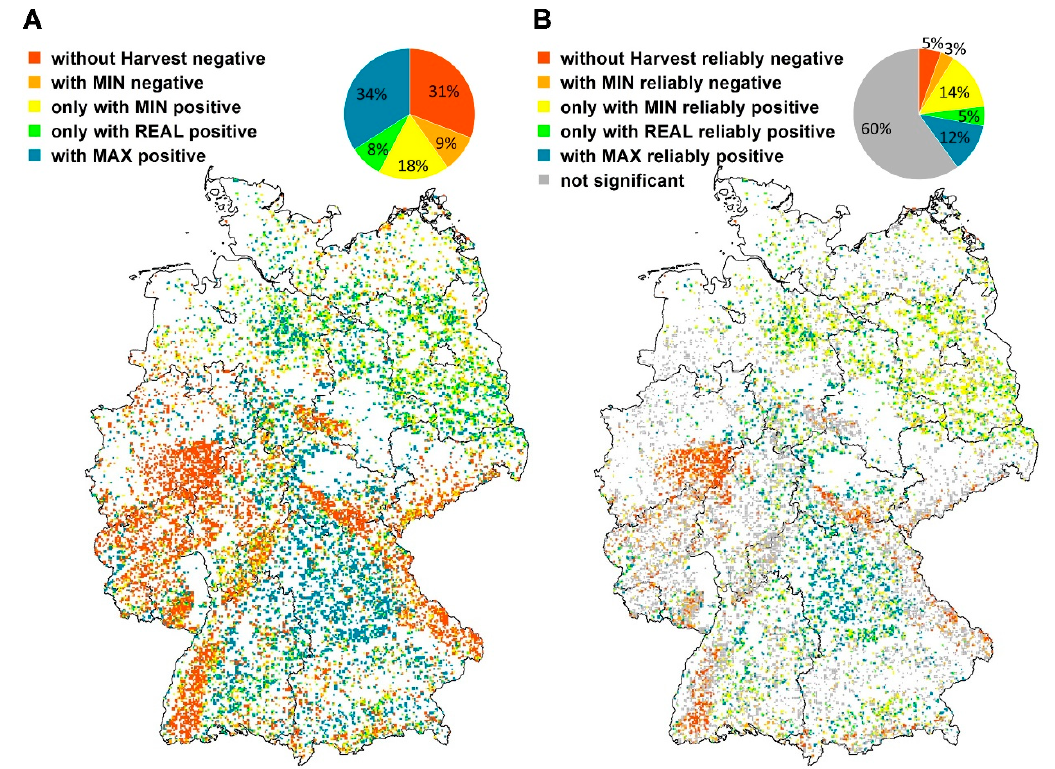
Figure 6. Spatial distribution of the base cations (Ca, Mg and K) that can be exported with the harvest scenarios MIN (yellow), REAL (green) and MAX (turquoise) without leading to negative nutrient balance of one or more elements ( A ). On the right map ( B ) the same data analysis is shown, incorporating the uncertainty of the models ( α < 0.1) to decide about possible harvest intensity. The sites that show negative (or significantly negative) balances without any harvest are marked in red and the sites where scenario MIN shows negative (or significantly negative) balances in orange.